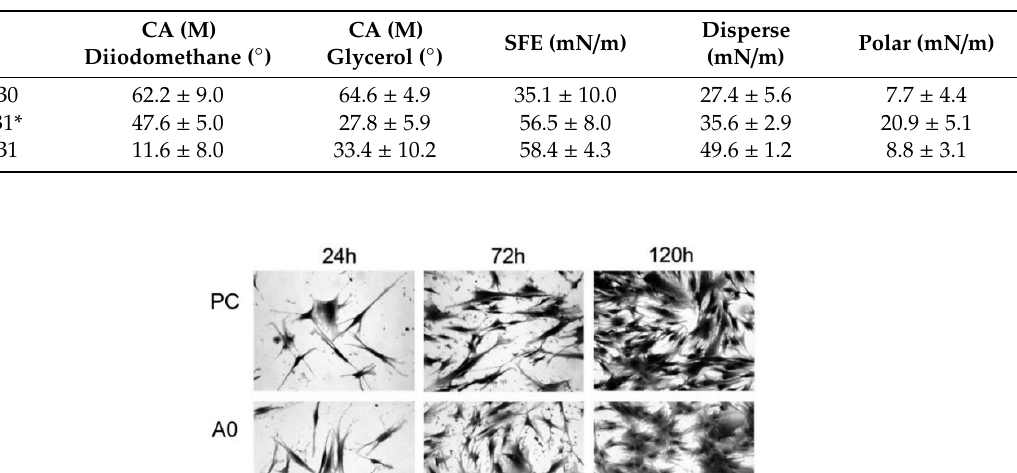
Table 2. Surface free energy (SFE), dispersive and polar parts of SFE, diiodomethane, and glycerol contact angles for Ti23Zr25Nb alloy after electrochemical etching (B1*) and electrochemical deposition (B1) in contrast to non-modified Ti23Zr25Nb alloy (B0).